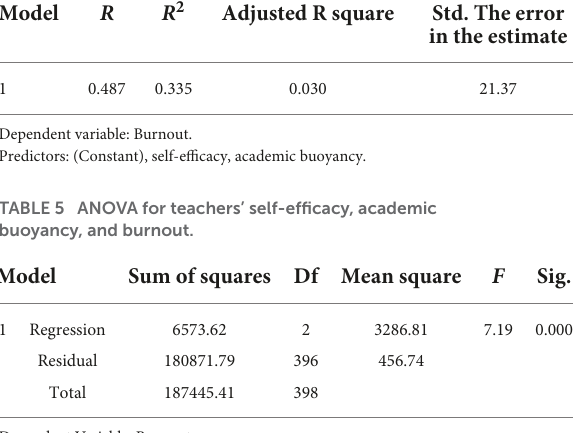
TABLE 4 Model summary for teachers’ self-efficacy, academic buoyancy, and burnout. Model